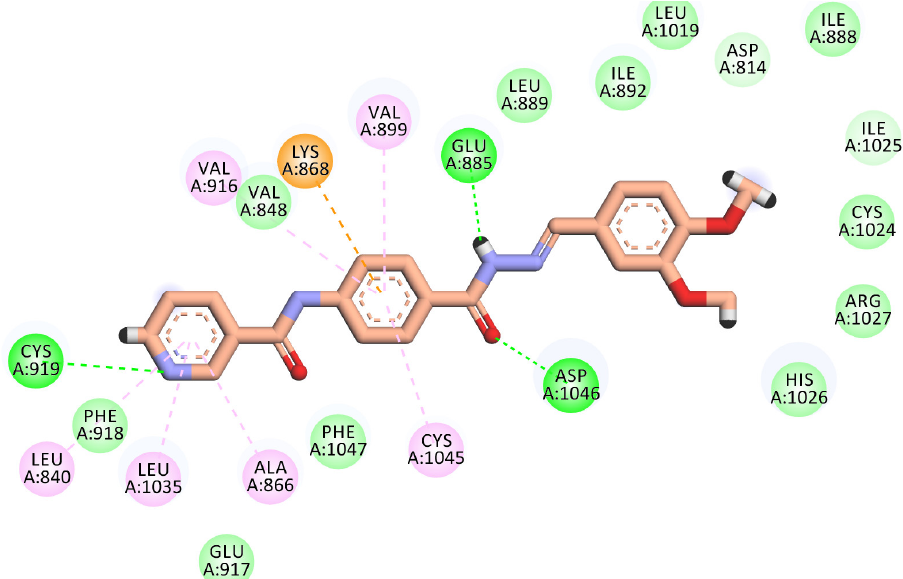
Figure 7. 2D binding mode of compound 7 into the VEGFR-2 active site. H-bonds (dashed green) were formed with Cys919, Glu885, and Asp1046. Hydrophobic interactions (dashed organ) were formed with Leu840, Leu1035, Ala866, Val916, Val899, Lys868, and Cys1045. The best-scored pose (−22.71 kcal/mol) of compound 8 mimicked sorafenib’s key interactions. It kept the H-bonding interaction with the essential amino acid Cys919 in the hinge region via the nitrogen of the pyridine ring. The pyridine head was much more stabilized by many hydrophobic interactions generated with Leu840, Leu1035, Cys919, and Ala866. Moreover, the phenyl linker was enclosed in the gatekeeper area through four hydrophobic interactions with Val899, Val916, Lys868, and Cys1045. Furthermore, the hydrazone moiety interacted as an H-bond donor and acceptor, producing essential H-bonding interactions with Glu885 and Asp1046 at the DGF motif. Finally, the N , N -dimethyl aniline tail occupied the hydrophobic allosteric site (Figure 8).